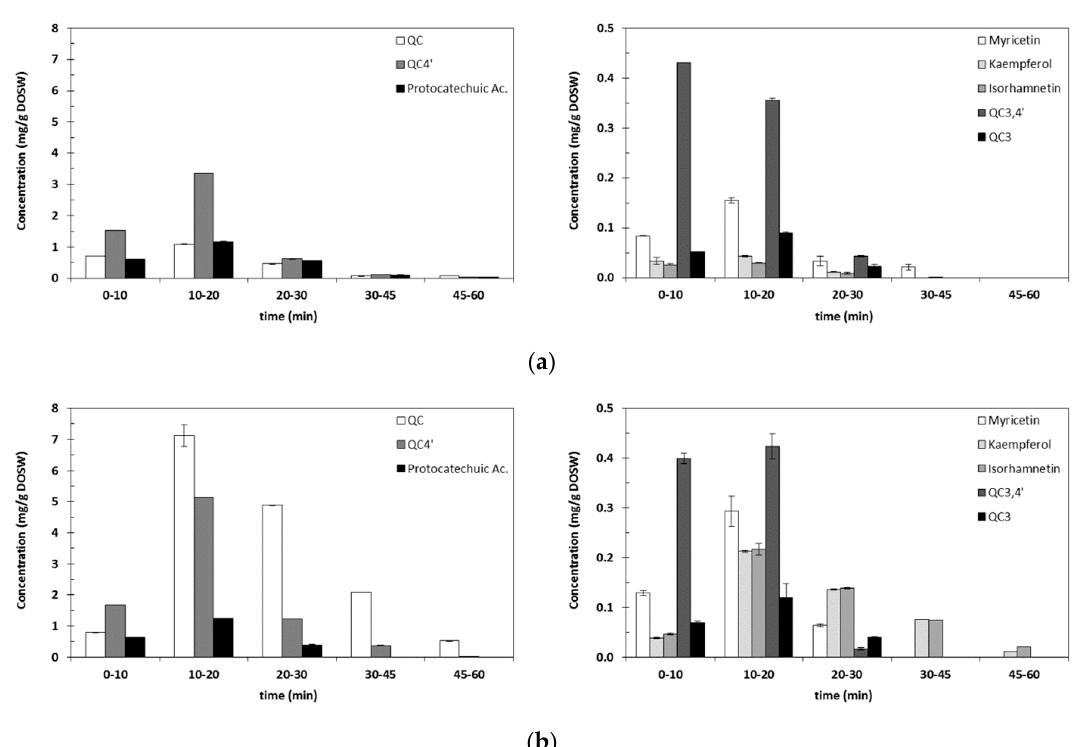
Figure 4. Flavonoids quantification after the extraction at 145 °C; ( a ) soluble fraction obtained at 145 °C as obtained after centrifugation. ( b ) After the addition of ethanol to the aqueous extracts.